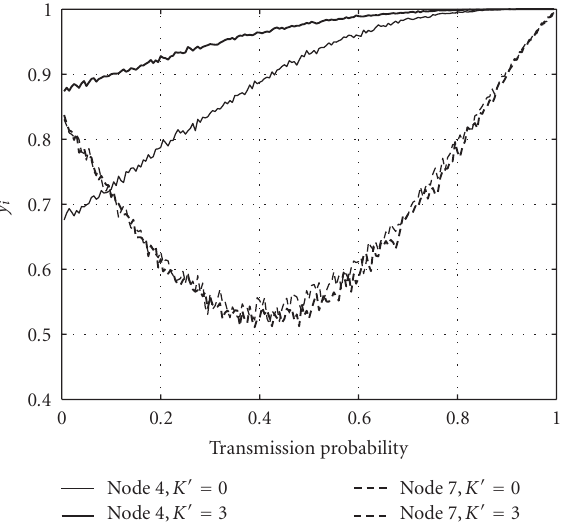
Figure 21: Delay of the dynamic ( K (cid:5) = 3) and static ( K (cid:5) = 0) cases for K = 4 (asymmetric network of Figure 11).